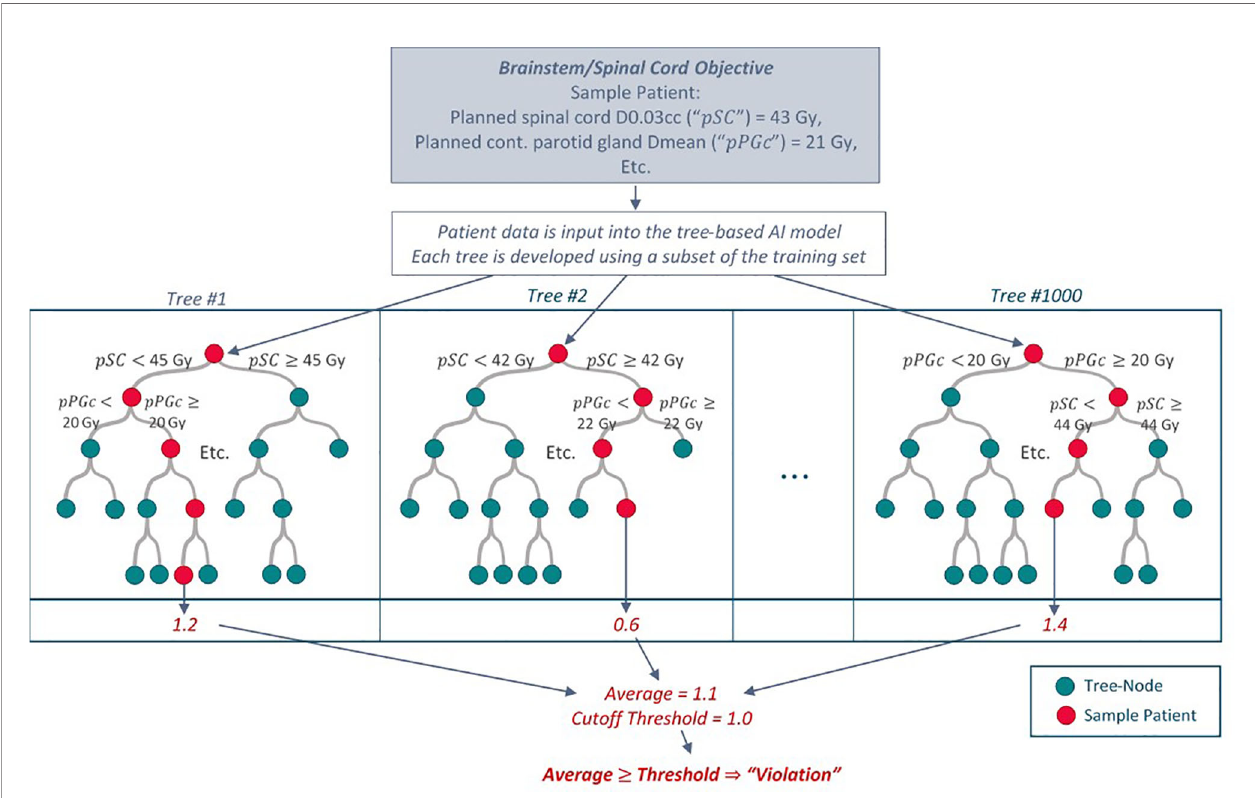
FIGURE 1 | Schematic of how the tree-based RF models predict an ART objective violation for a given patient with “ toy ” values for illustration purposes. Each tree within the model is developed using a random subset of patients in the training dataset. Additional speci fi cations are placed on how each tree is grown (only a random subset of predictors is available to split upon at each tree node). To predict an objective violation for a new patient, patient data is input into the model. An average violation estimate from all trees indicates whether the patient may require a replan